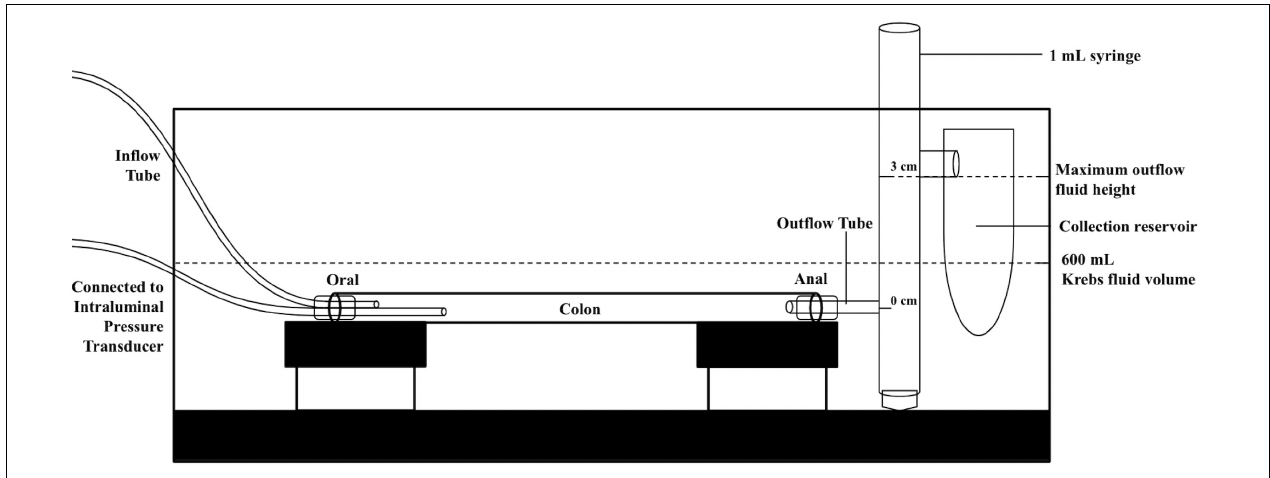
FIGURE 1 | Schematic of the colon bath setup to maintain 3 cm outflow pressure. For another experimental condition, the 1 mL syringe was replaced by an open collection reservoir to create 0 cm of outflow